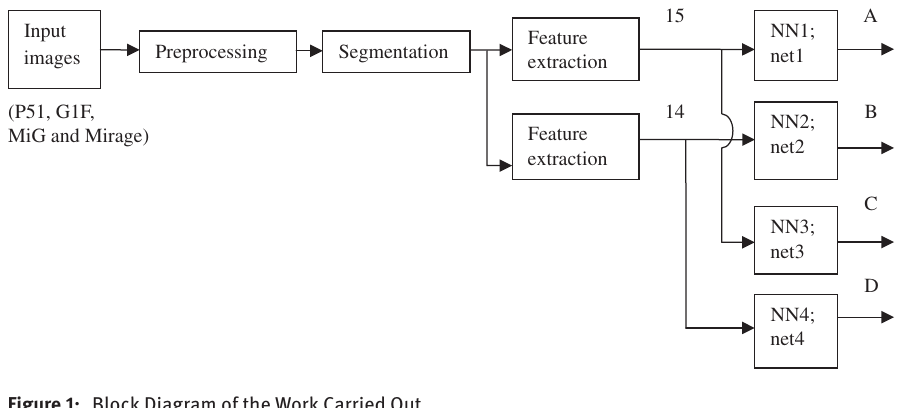
Figure 1: Block Diagram of the Work Carried